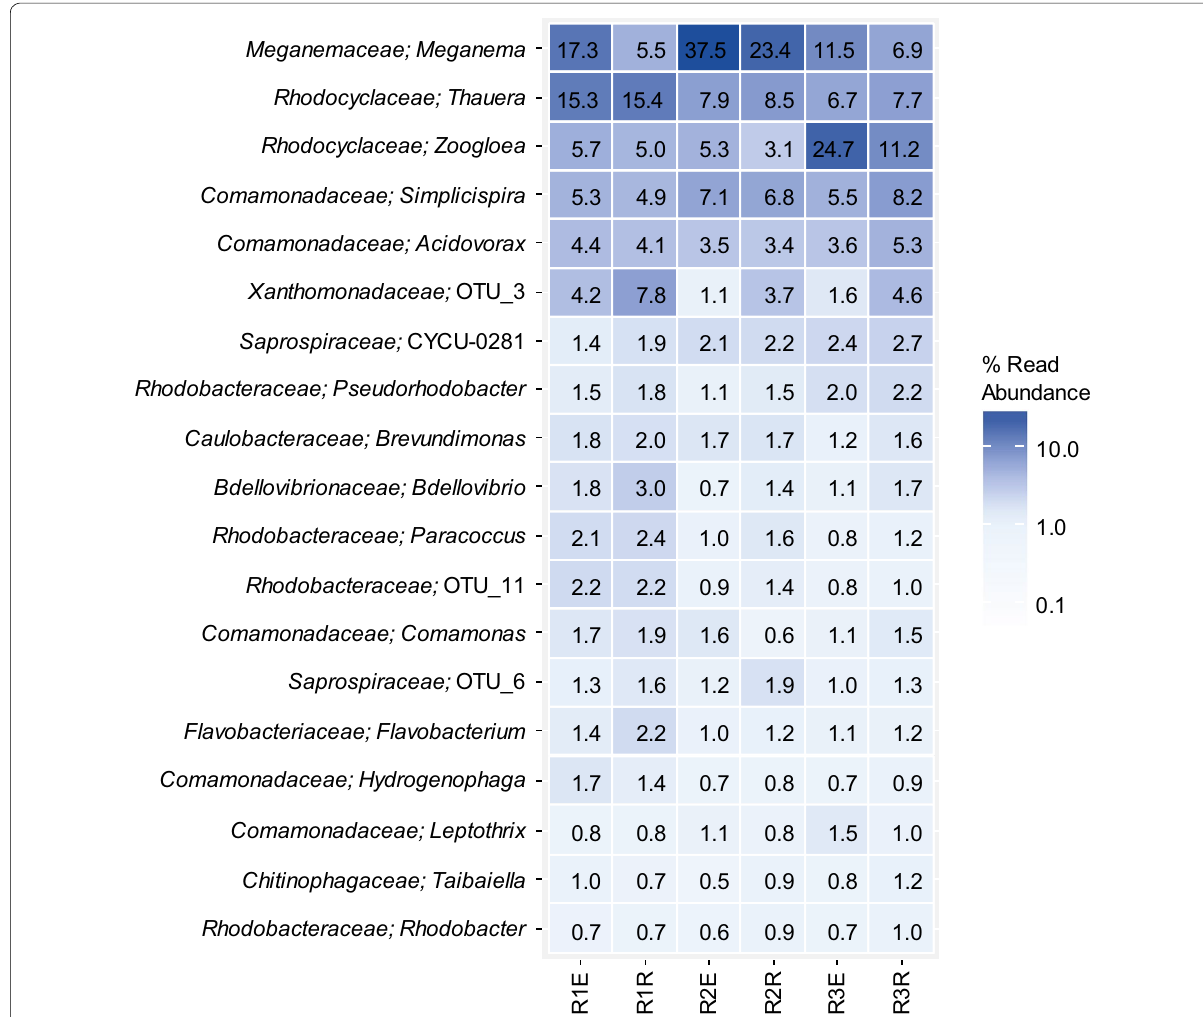
Fig. 2 Average relative read abundance (n 13) of the most abundant genera common for all six sample categories. These 19 genera add up = to 65 11% of the total population in the samples. R1E, R2E, R3E: effluent samples (suspended phase); R1R, R2R, R3R: samples from the reactor ± content (granular